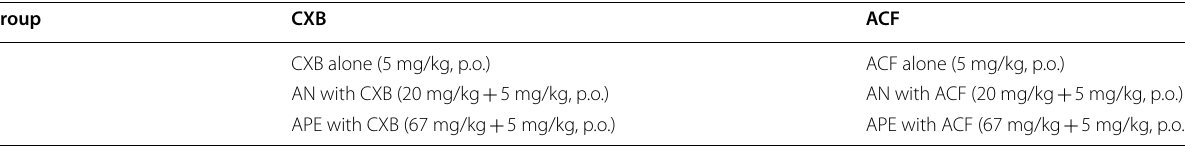
Table 1 Details of animal groups and dose for CXB and